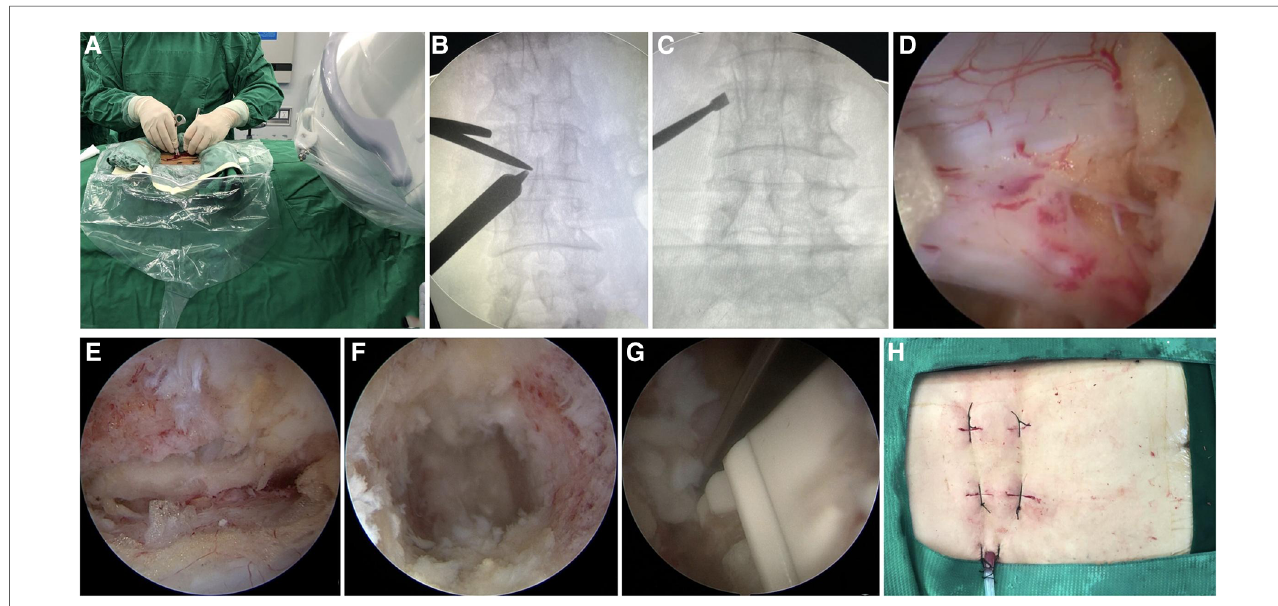
FIGURE 1 Intraoperative images of UBE-TLIF. ( A ) Operator creates two portals. ( B ) Location of the junction point of the serial dilators and the lamina dissector was con fi rmed by C-arm fl uoroscopy. ( C ) Target segment was con fi rmed by C-arm fl uoroscopy. ( D,E ) Endoscopic images of the dura, ipsilateral traversing root, and contralateral traversing root. ( F ) Endoscopic showed the intervertebral space with the cartilaginous endplate completely removed. ( G ) Cage was inserted under endoscope guidance. ( H ) Photo of the incision after completion of the